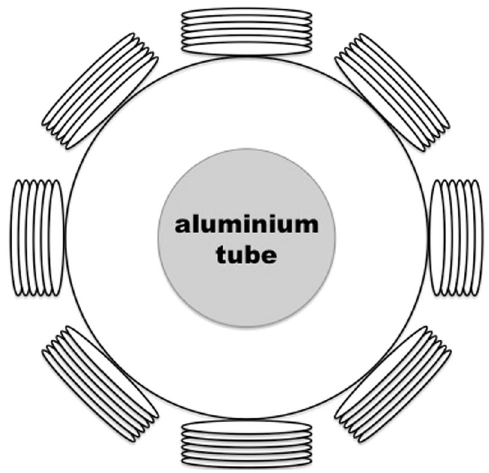
Figure 3. Experimental setup of an aluminium tube (OD50.76 mm) positioned in the centre of the imaging region.